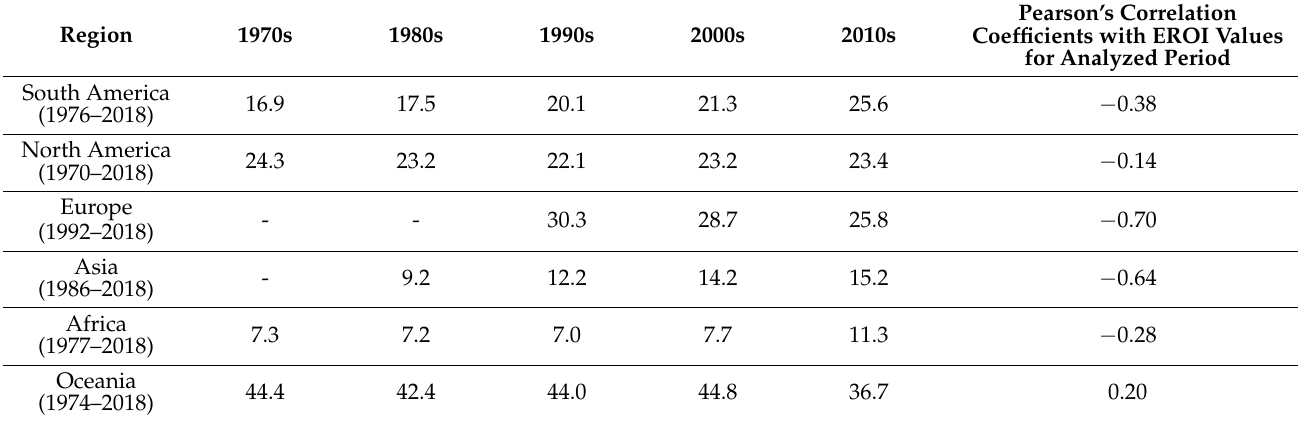
Table 2. Share of animal production in edible energy production for years 1970–2018 and its correlation coefficients with EROI values.